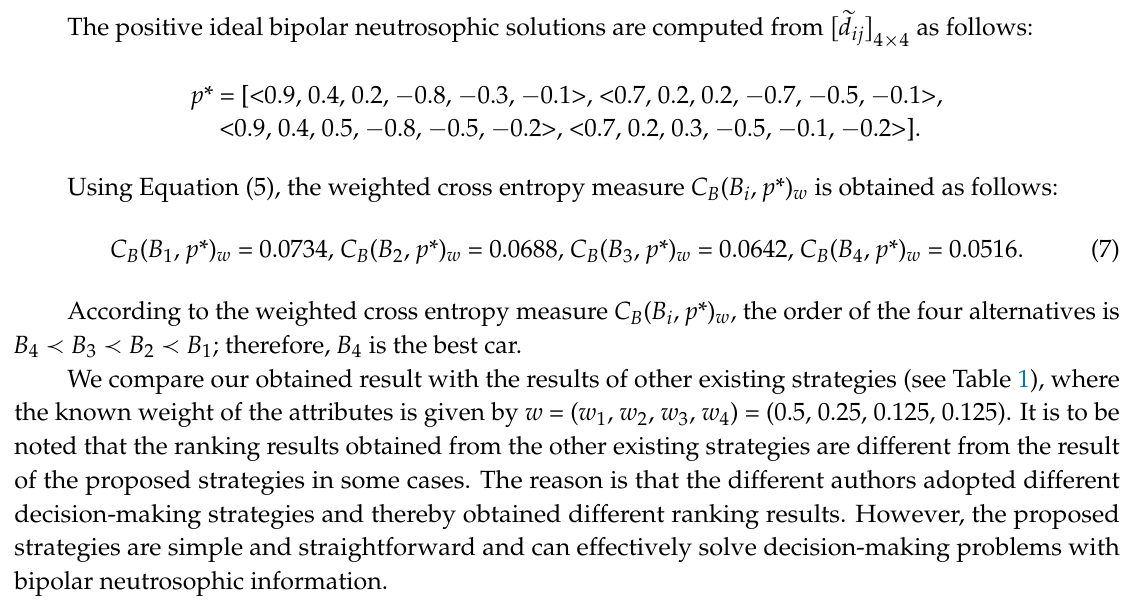
Table 1. The results of the car selection problem obtained from different